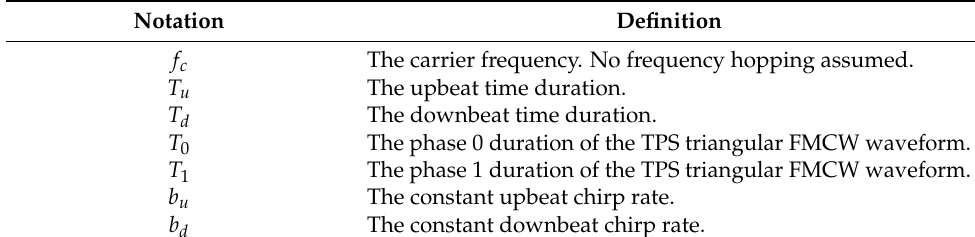
Table 1. Notations of the TPS triangular FMCW waveform.